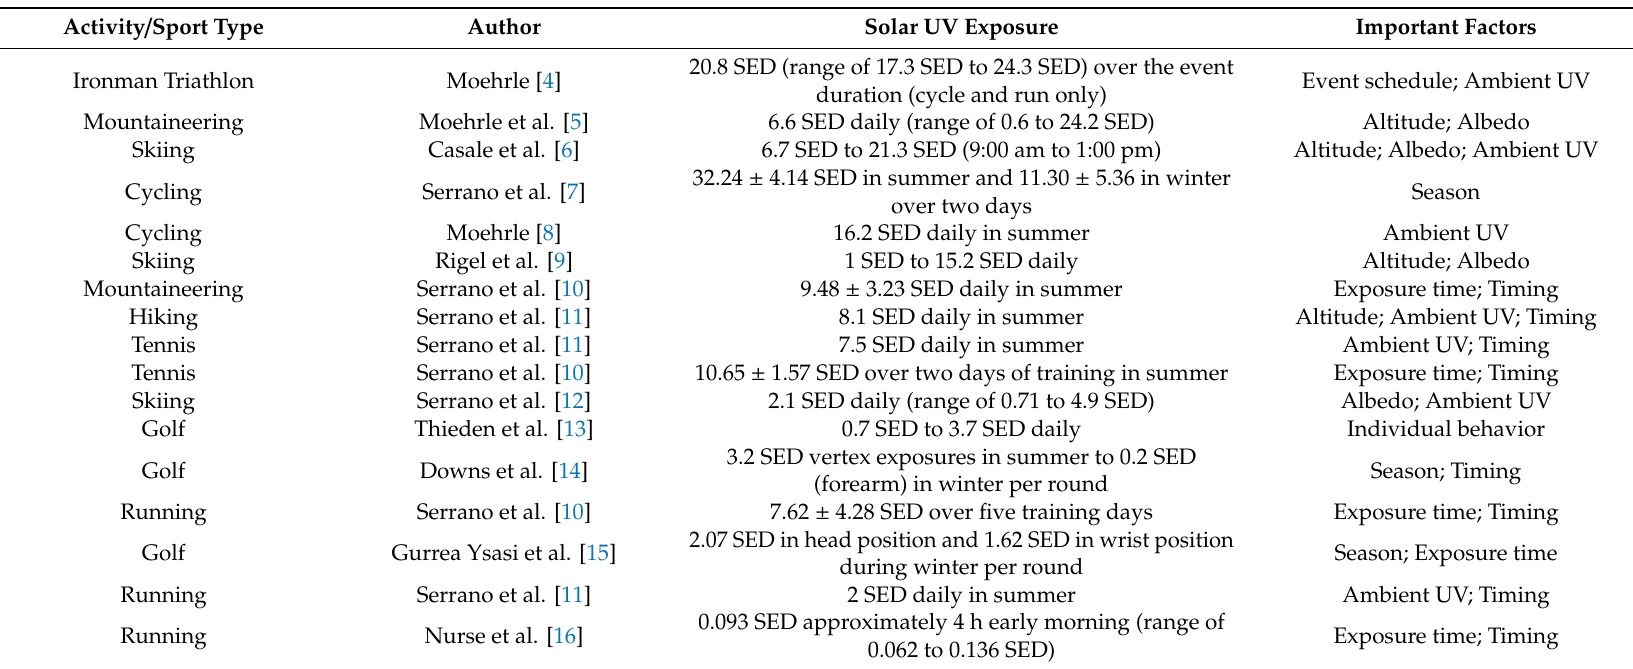
Table 1. A summary of recent studies demonstrating the variation in personal exposure measured using dosimeters across a range of outdoor sports. (SED: standard erythema